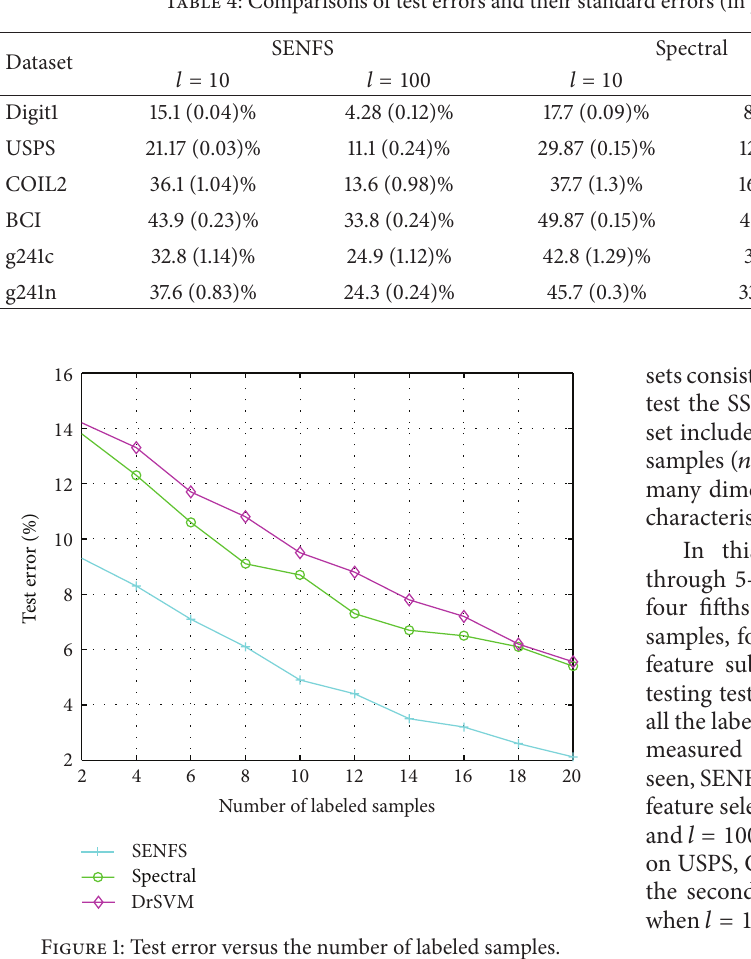
Figure 1: Test error versus the number of labeled samples.